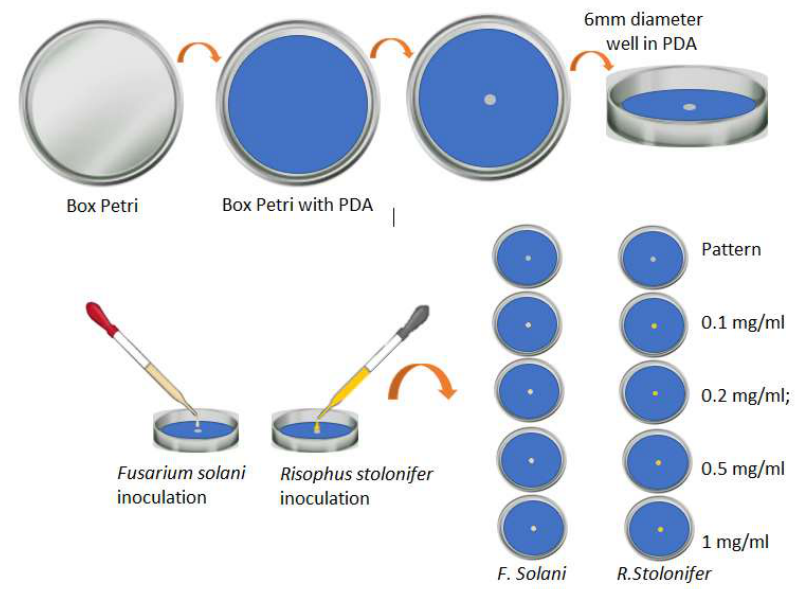
Figure 4. General scheme of the experiment carried out to evaluate the response of the two phytopathogens when placed in contact with AgNPs (own